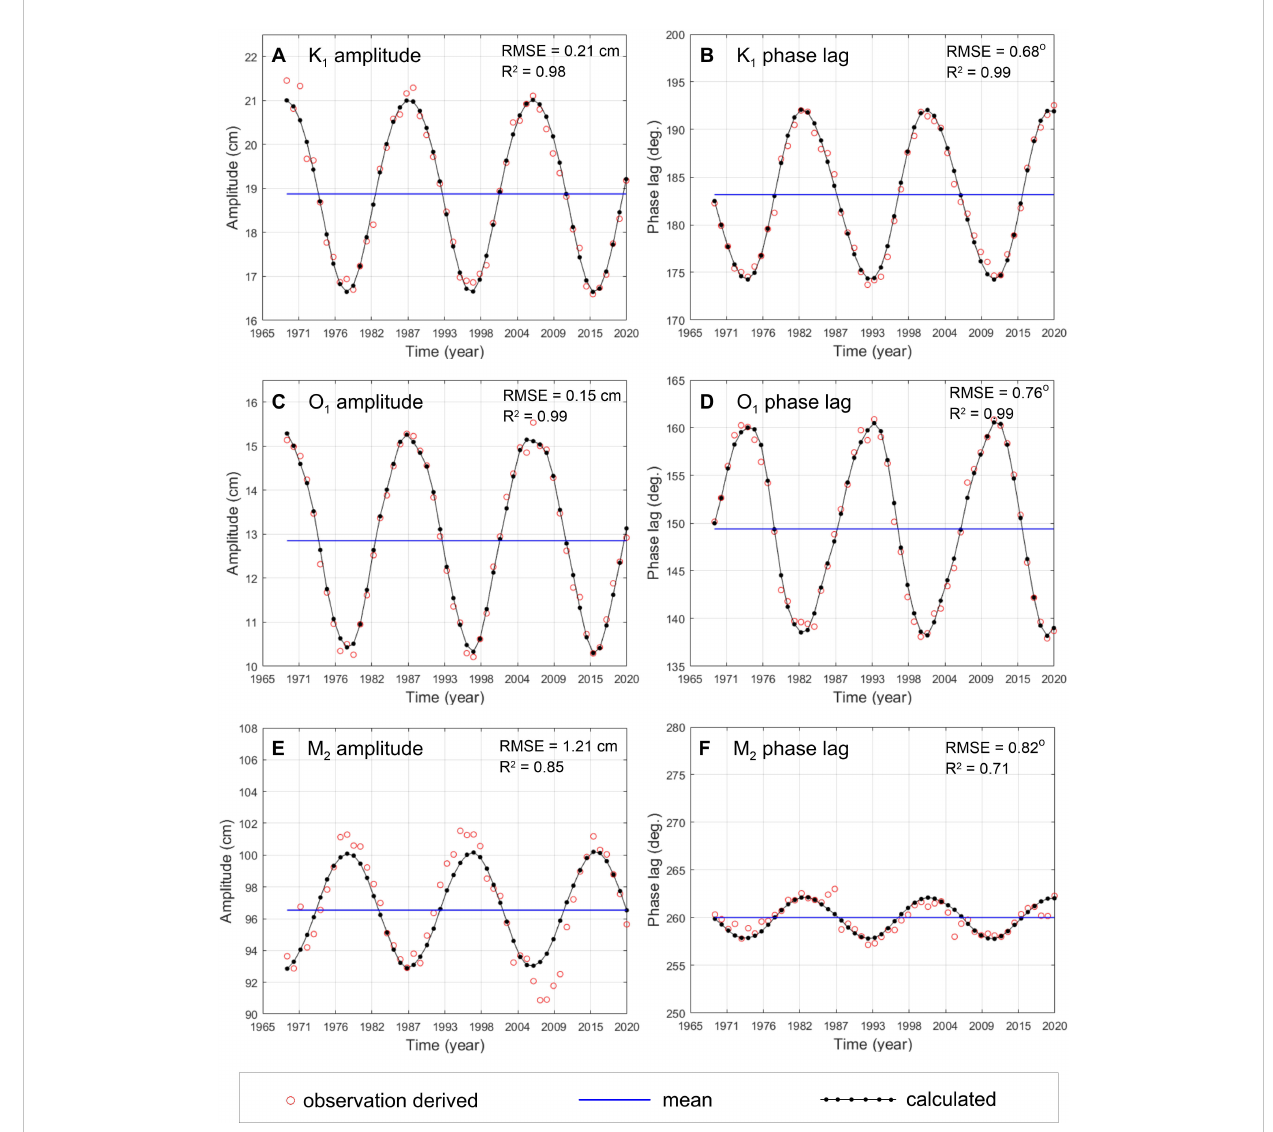
FIGURE 5 Annual variation in amplitudes (A, C, E) and phase lags (B, D, F) for the three main lunar tidal constituents (K 1 , O 1 and M 2 ) from 1969 to 2020 at Yeosu, Korea. Red open circles are the harmonic constants estimated using year-long observation records with T_Tide (Pawlowicz et al., 2002), without nodal modulation correction (i.e., with single nodal amplitude factor and nodal angle values employed for each constituent from the middle of each observation year). Blue lines are the mean tidal constants over the entire 52-year record. The black solid dots on black lines are the annual harmonic constants calculated by multiplying the mean tidal constants by the nodal amplitude factors and nodal angles for each year as derived from T_Tide ’ s t_vuf.m program. Note that linear trends were removed from the M 2 tidal constants